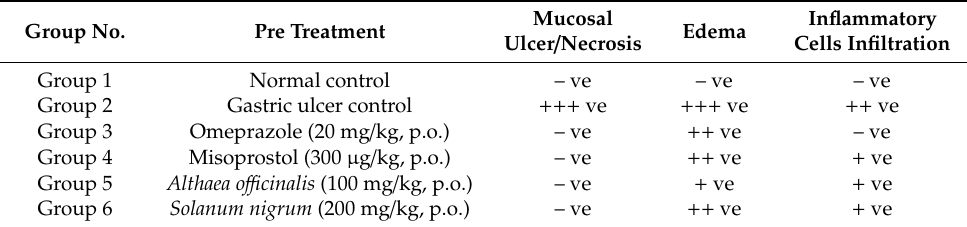
Table 2. Scoring of histopathological examination images for stomach from different groups (pyloric ligation/indomethacin model).